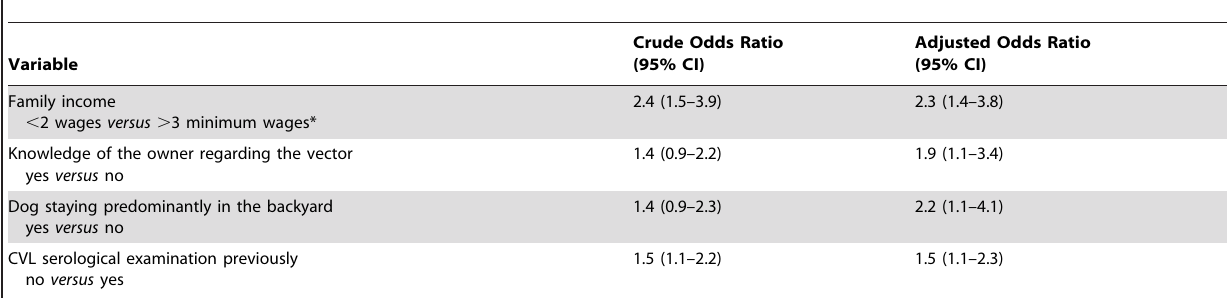
Table 3. Risk factors for Leishmania infantum infection in seronegative dogs according to hierarchical model, Brazil 2008.